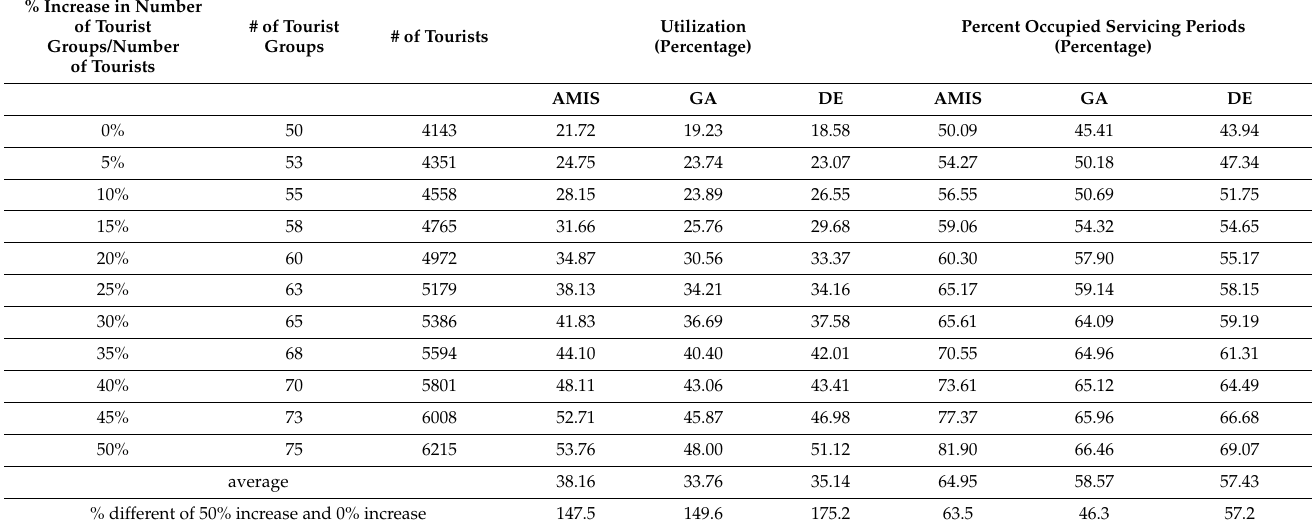
Table 12. Utilization of a hotel using different levels of